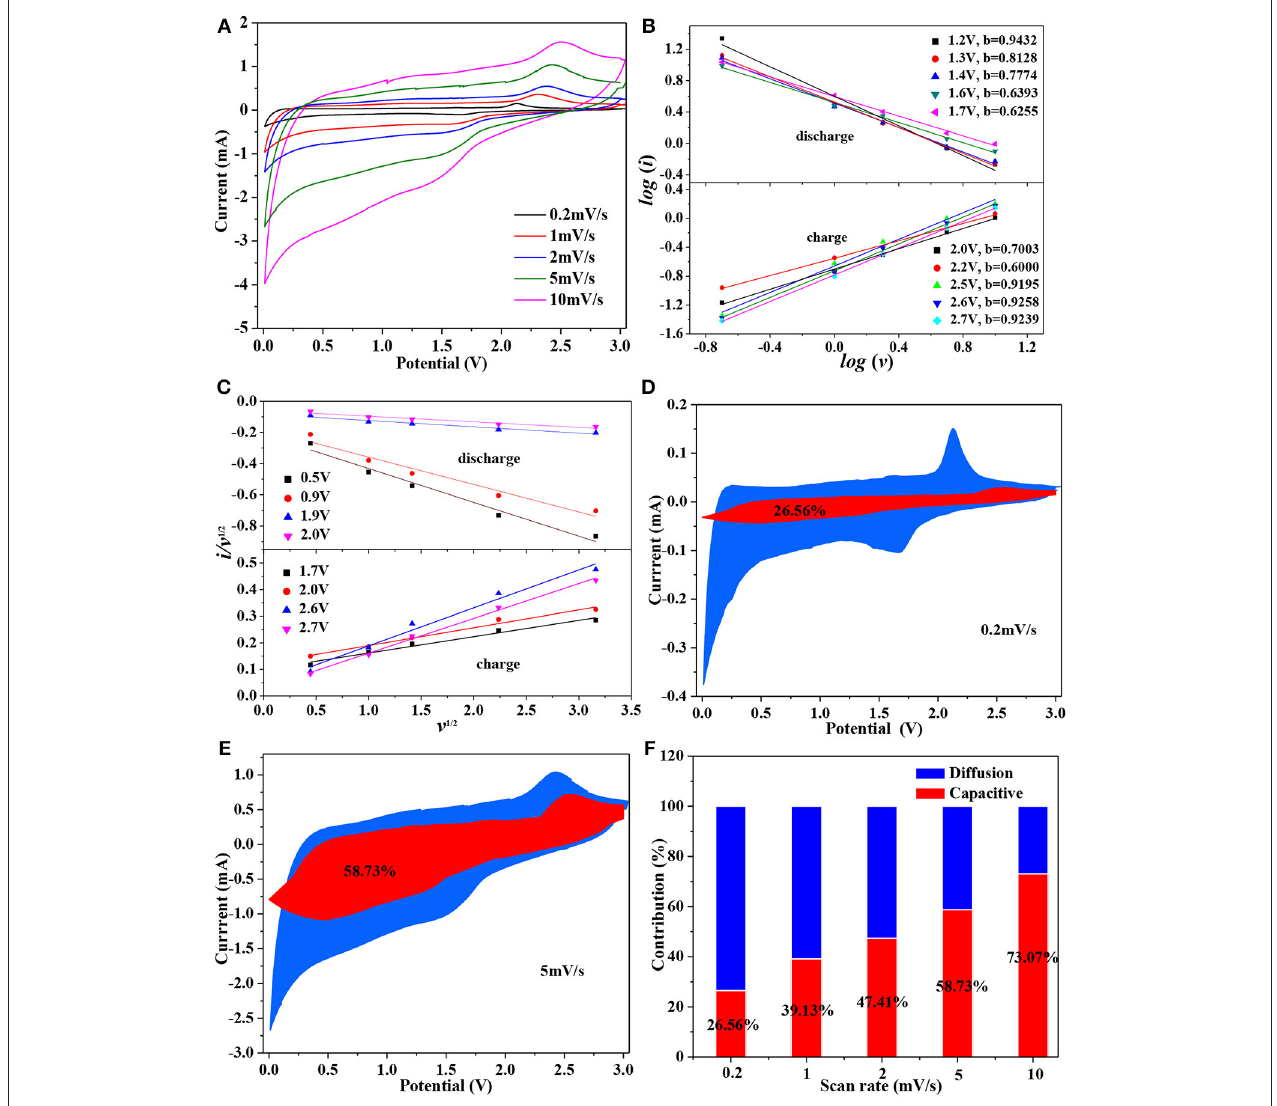
FIGURE 6 | (A) CV curves of Mo-TiO 2 @NC at different scan rates; (B) the relationship between log i and log ν ; (C) the plots of i(V)/ ν 1 / 2 vs . ν 1 / 2 used for calculating constants k 1 and k 2 at different potentials; capacitive current contribution at different scan rates. (D) 0.2 mV/s, (E) 5 mV/s; (F) the proportion of capacitive current contribution at different scan